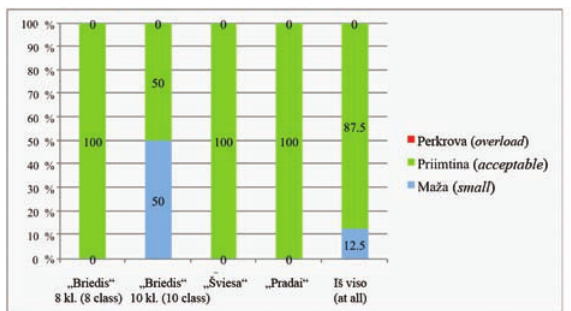
Fig. 6 . Graphic strain in the analysed economic maps of scholastic geographical atlases